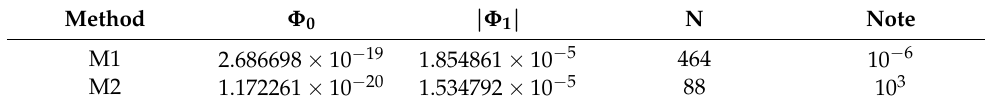
Table 1. Quantitative indicators of calculations for methods M1 and